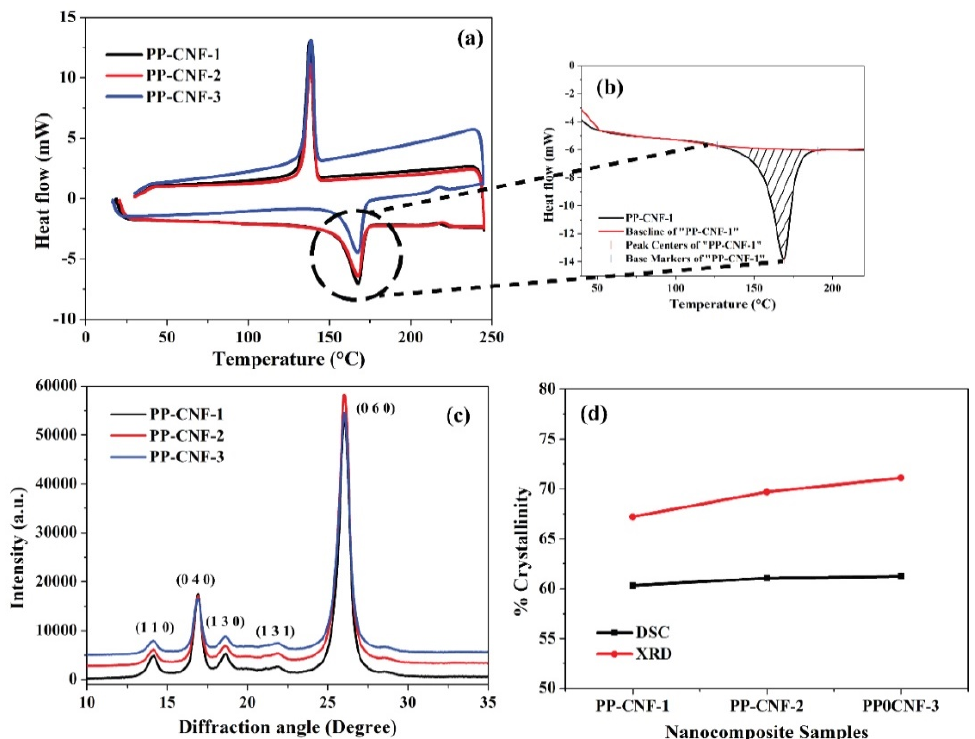
Figure 7. ( a ) Melting and recrystallization temperature by DSC, ( b ) % crystallinity calculation by DSC, ( c ) XRD study to see the crystalline plane of PP after recycling, and ( d ) %crystallinity comparison calculated by DSC and XRD of PP-CNF nanocomposites.